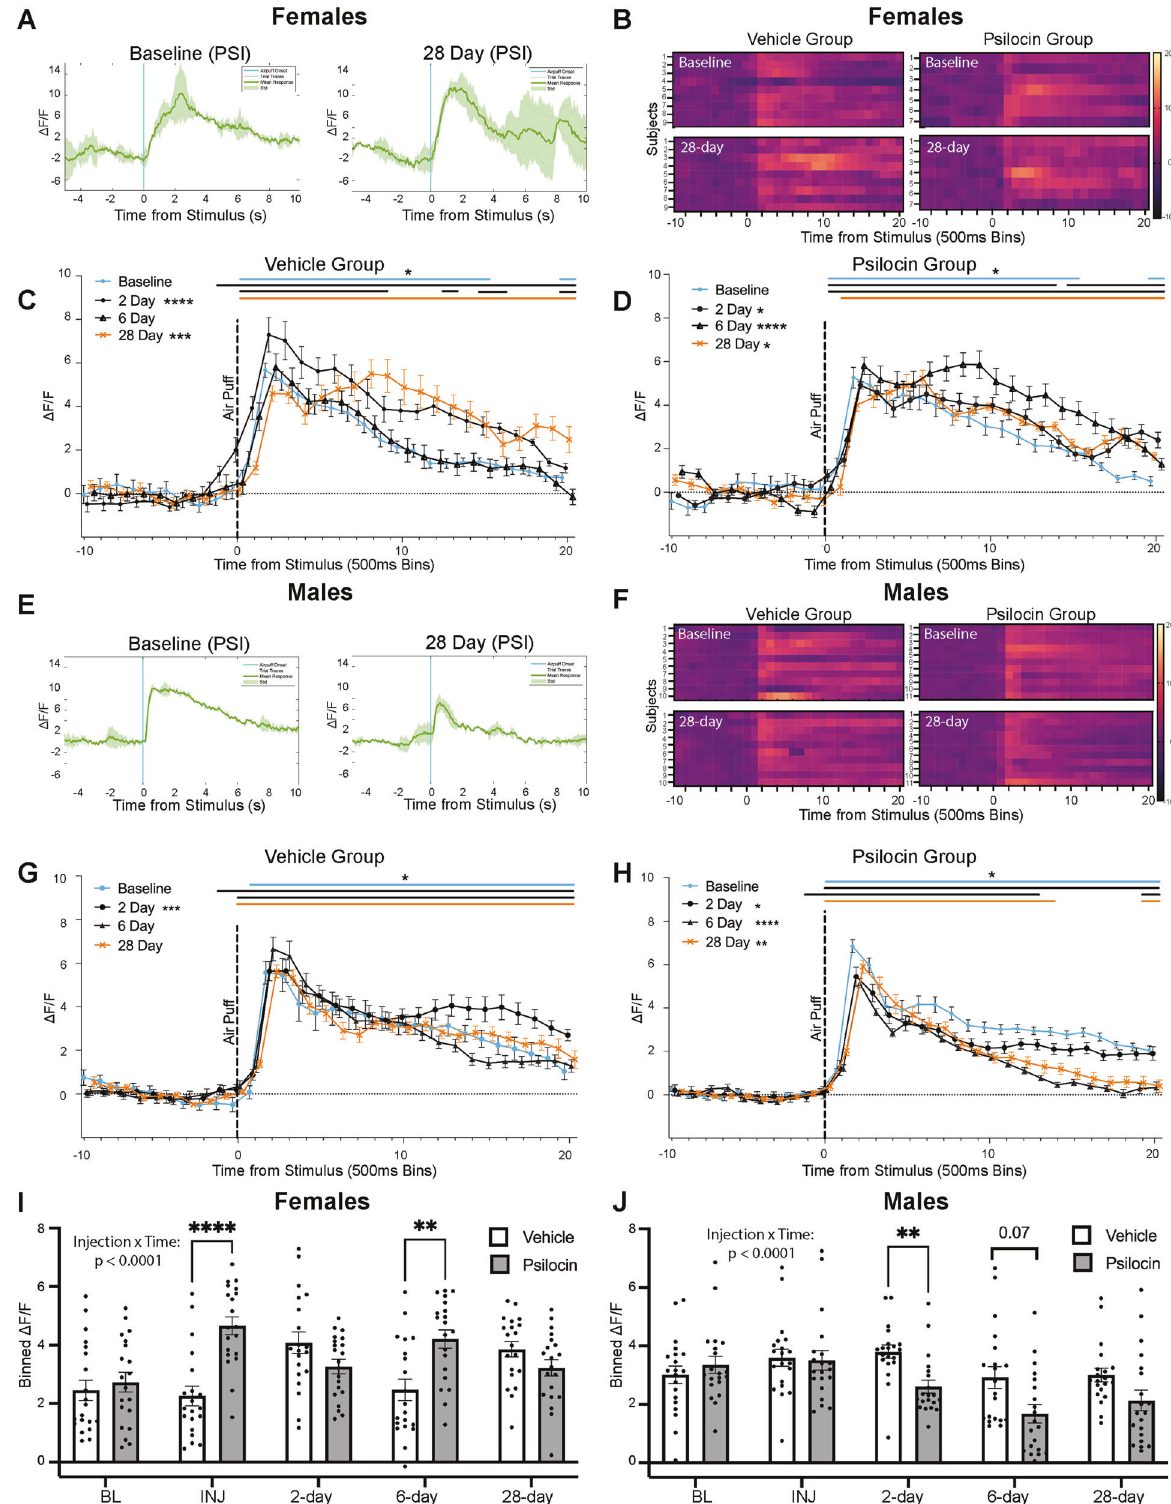
Rearing was de fi ned as standing on the two hindlegs, regardless of any balancing on the walls of the box. In females, there were no differences in overall locomotion between vehicle and psilocin groups ( F Interaction (3,42) = 0.2118, p = 0.89; F Injection (1,14) = 2.238, = 0.6065, ε = 0.83, p = 0.59; Fig. 4A). p = 0.16; F Time (2.497,34.95)